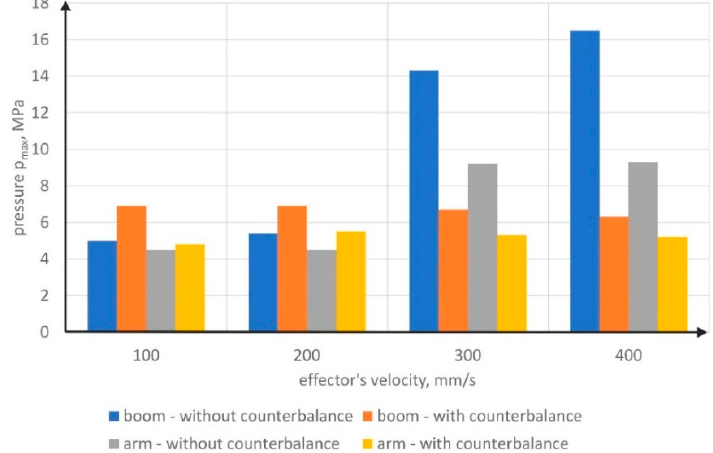
Figure 20. Maximum pressures, p max , for different speeds of the effector movement.